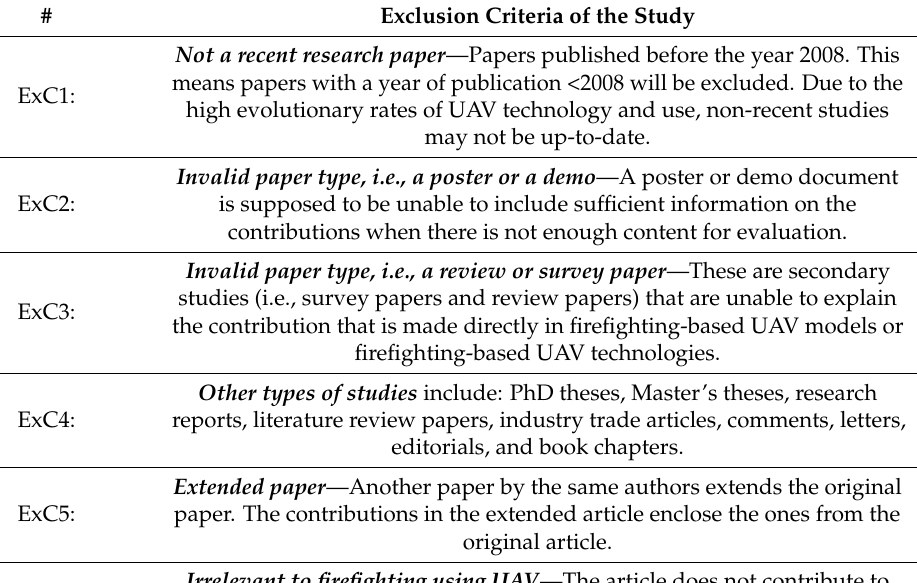
Table 3. Exclusion criteria determined in this SLR